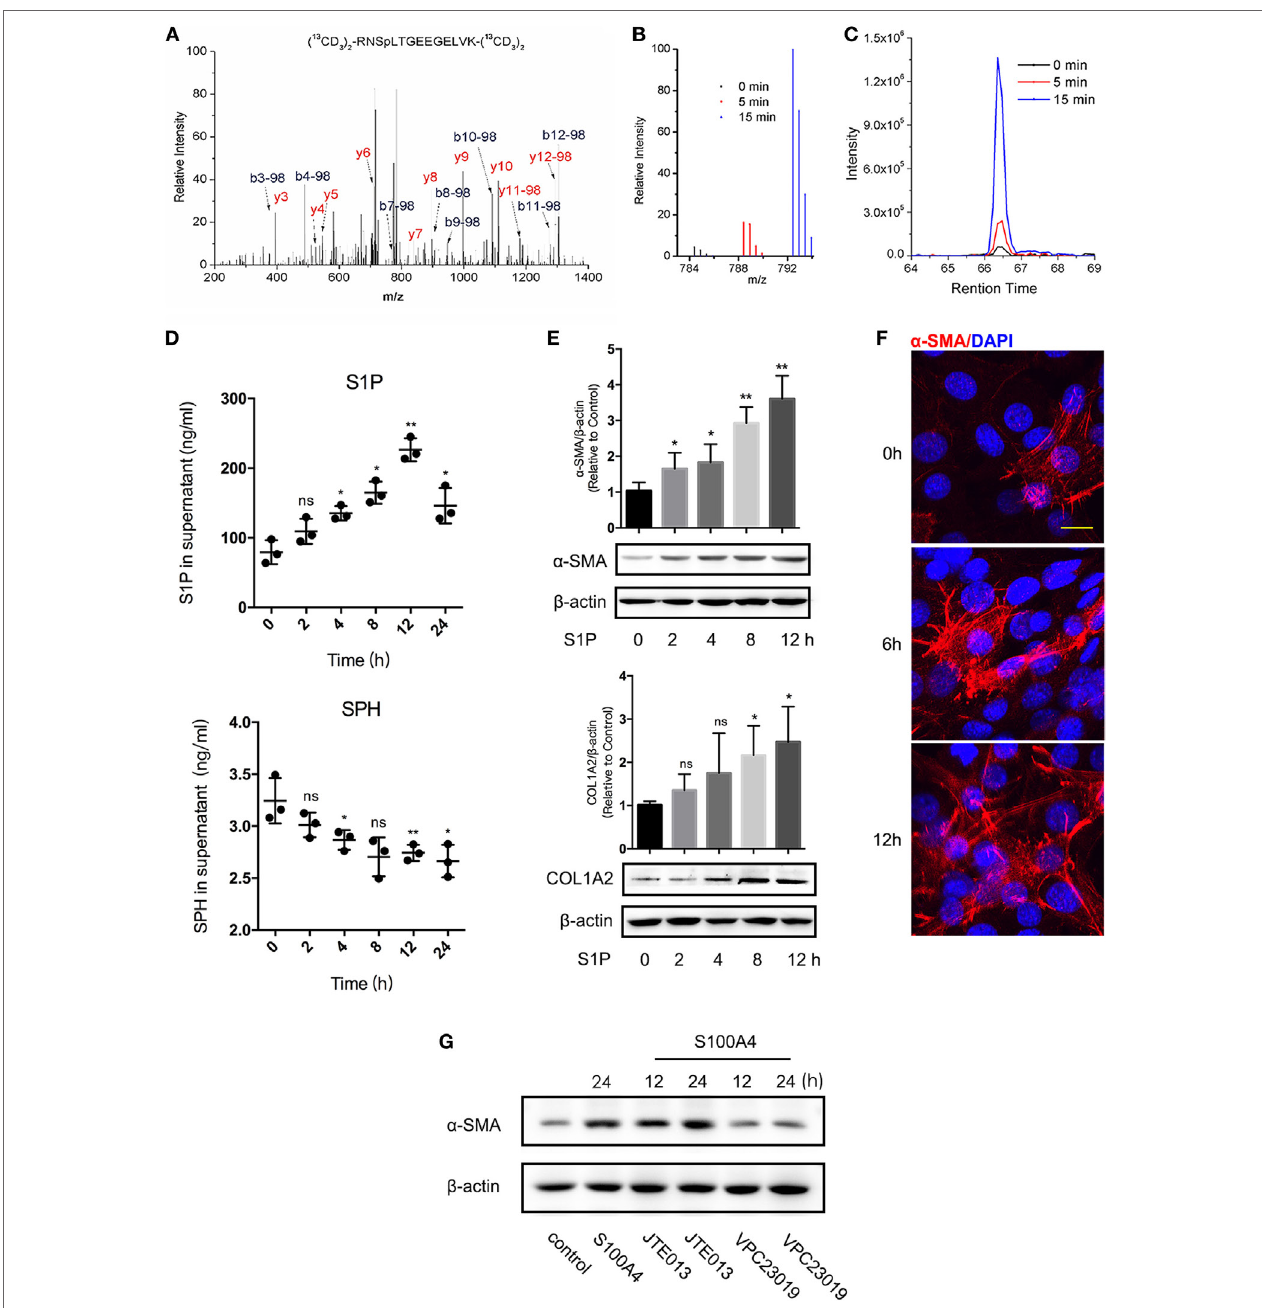
FigUre 4 | Sphingosine-1-phosphate (S1P) is essential in S100A4-mediated lung fibroblast activation. Fibroblasts were isolated from lung tissues of untreated S100A4 − / − mice. Fibroblasts were isolated from lung tissues of untreated S100A4 − / − mice. (a–c) Cells (1 × 10 8 ) were cultured with recombinant S100A4 (1 µg/ml) for 5 (red) or 15 min (blue) or were left untreated (black). Total proteins were extracted, labeled, and subjected to MS/MS spectroscopy. The phosphopeptide RNSpLTGEEGELVK identified SGPP1 as different in the three treatment groups. (a) MS/MS spectra of the heavy dimethyl-labeled phosphopeptide. (B) MS spectrum of the light, medium, and heavy dimethyl-labeled phosphopeptide. (c) XIC peaks of the phosphopeptide abundance. (D) Fibroblasts were (1 × 10 5 ) cultured for up to 24 h in the presence of recombinant S100A4 (1 µg/ml) or left untreated. Production of S1P (upper panel) and sphingosine (SPH) (lower panel) was determined from the culture supernatants by enzyme-linked immunosorbent assay. Three independent experiments with n = 5 per group and experiment. Mean ± SEM. (e,F) Fibroblasts (1 × 10 5 ) were cultured for up to 12 h in the presence of S1P (20 µM). (e) Protein levels of α -SMA and COL1A2 were evaluated by western blot analysis as described for Figure 3c . Three independent experiments with triplicate determinations. Representative images and mean ± SEM, * p < 0.05 and ** p < 0.01, Kruskal-Wallis compared with control cultures without S1P. (F) Cells were stained for α -SMA (red) by immunofluorescence; nuclei (blue) counterstained with 4 ′ ,6-diamidino-2-phenylindole (DAPI). Representative images from three independent experiments from n = 3 cultures per experiment, scale bar 25 µm. (g) Fibroblasts (1 × 10 5 ) were treated with S100A4 combined with JTE013 (1 µM) or VPC23019 (10 µM) for up to 24 h. α -SMA or β -actin was shown by western blot analysis as described for Figure 3c . Representative images from two independent experiments with n = 3 cultures per